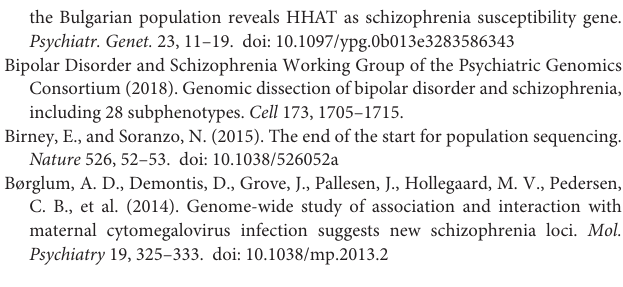
Supplementary Table 1 | Clinical characterization. PANSS, Positive and Negative Syndrome Scale. Supplementary Table 2 | CNVs identified. Chr, Chromosome; bp, base pair; Start (bp), Starting position of the CNV; End (bp), Ending position of the CNV;